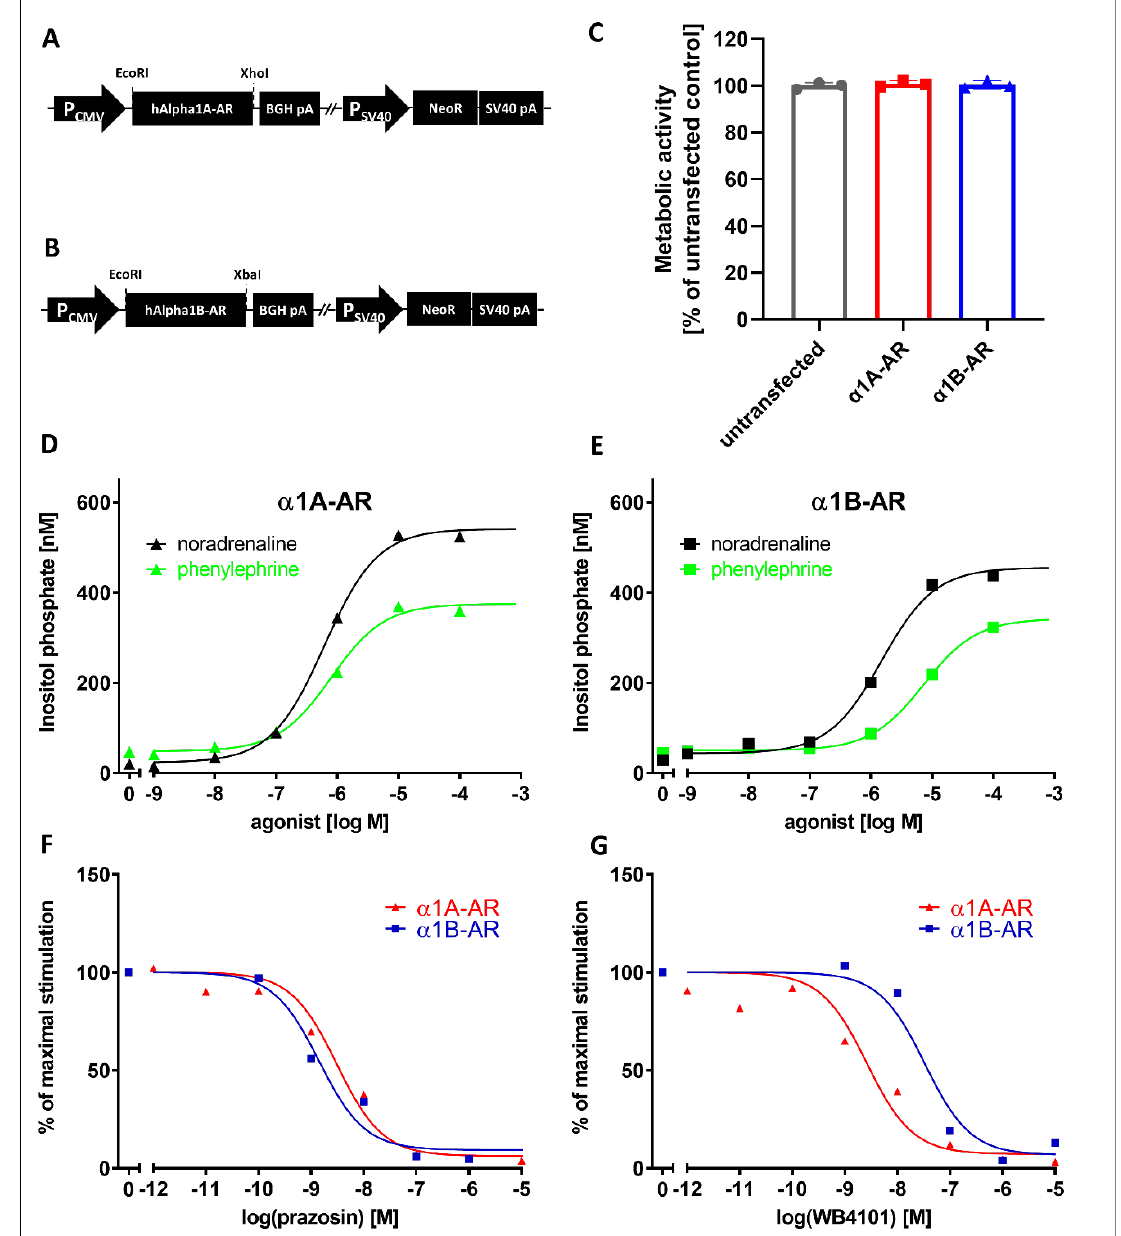
Figure 1. The creation and functional characterization of cell lines stably expressing the α 1A- and α 1B-adrenergic receptor subtypes in PC12 cells. Expression cassettes of pcDNA3.1+ plasmids used to express human ( A ) α1A - and ( B ) α1B - adrenergic receptors. ( C ) Metabolic activity of untransfected and receptor-expressing lines. Second messenger response of ( D ) α1A - and ( E ) α1B -adrenergic receptor-expressing cells to stimulation with the agonists noradrenaline (black) and phenylephrine (green). Second messenger response to a submaximal (EC 90 ) noradrenaline concentration in the presence of the antagonists ( F ) prazosin and ( G ) WB4101. P CMV — CMV promoter; hAlpha1A/B-AR —human α1A - and α1B - adrenergic receptors; P SV40 — SV40 promoter; NeoR — neomycin resistance gene; BGH pA — bovine growth hormone polyA; SV40 pA — SV40 polyadenylation site. Data are shown as the mean ± SEM, n = 2 – 4 wells.